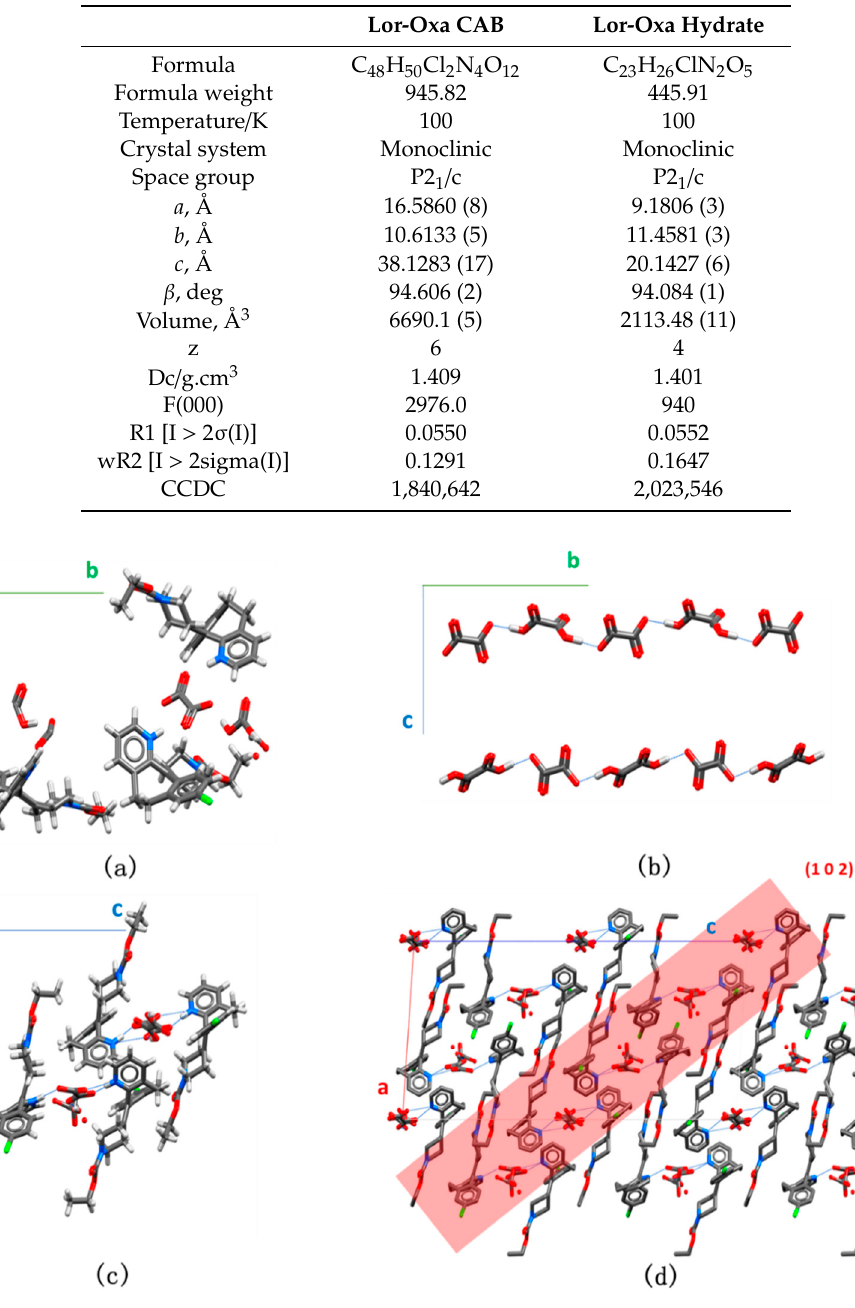
Figure 2. Crystal structure of Lor-Oxa CAB: ( a ) asymmetric unit; ( b ) oxalic acid chains; ( c ) composite column showing the interactions between an Oxa chain and surrounding Lor molecules (viewed into b axis); ( d ) Crystal structure viewed into b axis (hydrogens are omitted for clarity) . Table 1. Crystallographic data for Lor-Oxa CAB and Lor-Oxa hydrate .